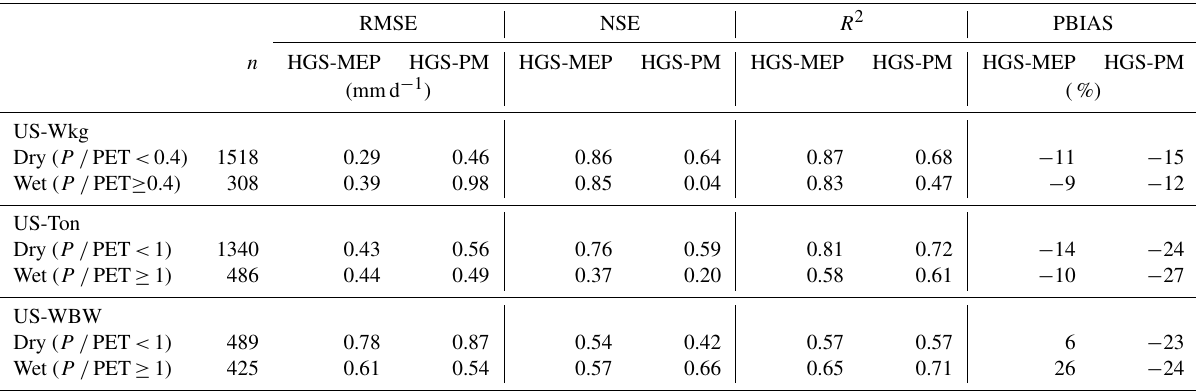
Table 5. Performance of the HGS-MEP and HGS with Penman–Monteith (HGS-PM) models when simulating daily mean total terrestrial evaporation ( E ) during dry and wet periods, as represented by the root-mean-square error (RMSE), Nash–Sutcliffe efficiency (NSE), coeffi- cient of determination ( R 2 ) and percentage bias (PBIAS). n represents the number of days. RMSE NSE R